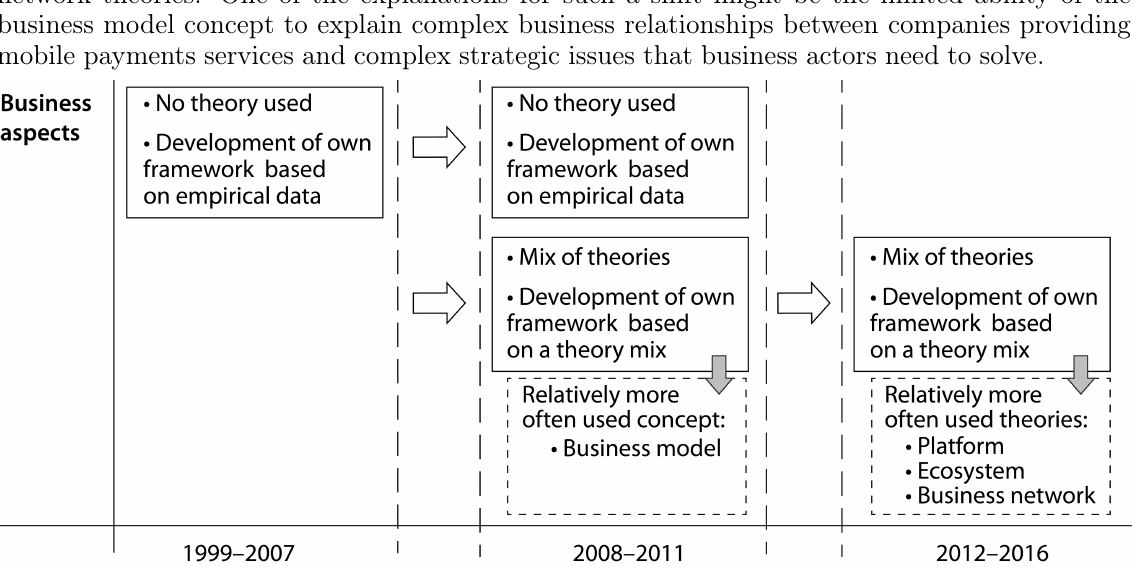
Fig. 9. Dynamic of theoretical base evolution within business aspects